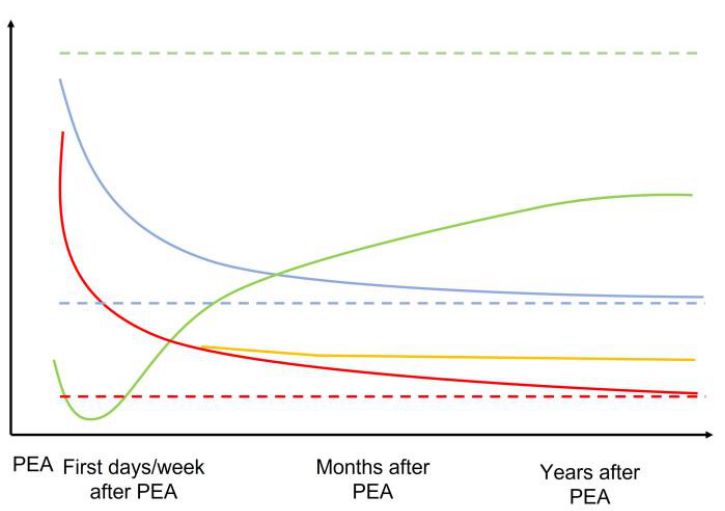
Figure 3. Schematic representation of the evolution of the mPAP, RV geometry, and RV function across time after PEA. The dotted line represents the normal expected values for each parameter. Green = RV function. Blue = RV geometry and dilatation. Red = mPAP if normalized. Orange = mPAP if residual PH after PEA. Dotted lines represent normal situations.